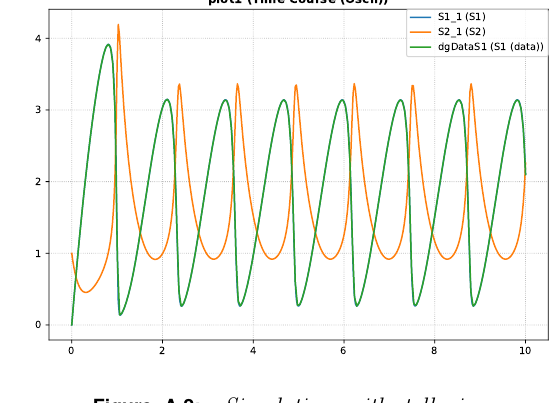
Figure A.2: Simulation with tellurium